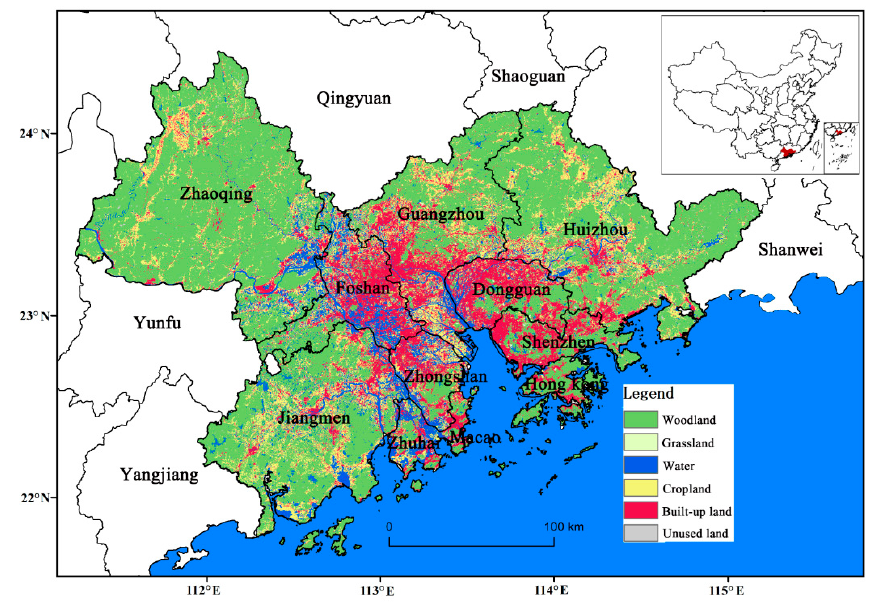
Figure 1. Land use and land cover (LULC) types in the “Greater Bay Area” (GBA). Land use and land cover (LULC) data in 2018, with a spatial resolution of 30 m, was provided by the Resources and Environmental Scientific Data Center (RESDC) of the Chinese Academy of Sciences (CAS) (http://www.resdc.cn/ accessed on 11 June 2019). Population distribution data with a 100 m resolution in 2018 was obtained from WorldPop (https://www.worldpop.org/ accessed on 26 June 2019). Landsat 8 OLI_TIRS satellite remote sensing images were downloaded from the U.S. Geological Survey (http:// earthexplorer.usgs.gov/ accessed on 23 August 2019) to map the land surface temperature (LST) in the GBA. Due to severe cloud obstruction in 2018, this study used the most complete and cleanest remote sensing images in the summer daytimes (from June to September) of 2019. The LST data with spatial resolution of 100 m was estimated through a practical split-window algorithm from the Thermal Infrared Sensor (TIRS) onboard Landsat 8